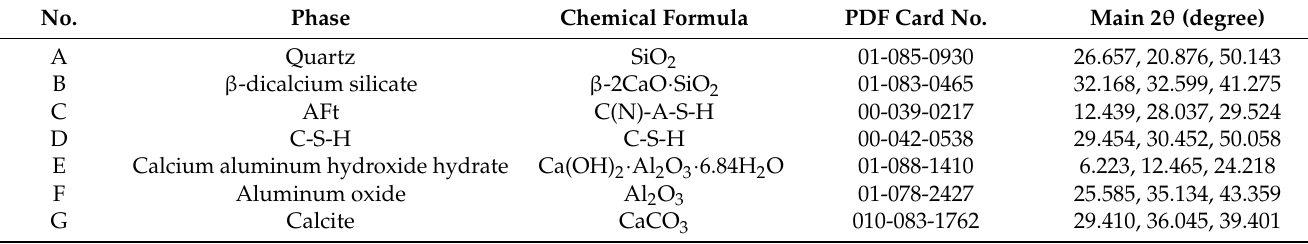
Table 3. Information on mineral phases of hydration synthesis of different CSS pavement base